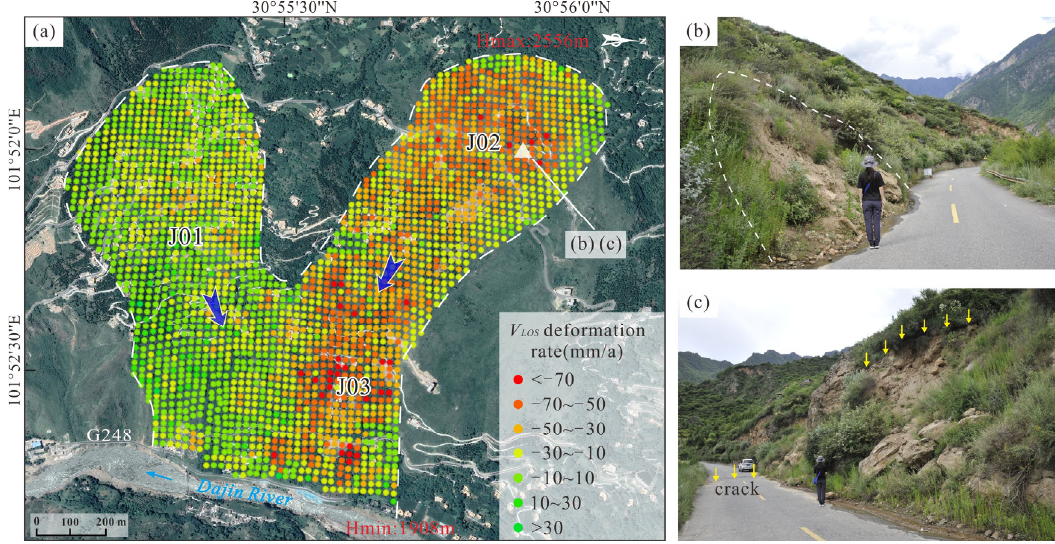
Figure 8. Deformation of the Jiaju landslide (H01); ( a ) InSAR deformation map of the Jiaju landslide; ( b ) the rear edge collapse (mirror to NE); ( c ) road cracks and rockfall (mirror to N).